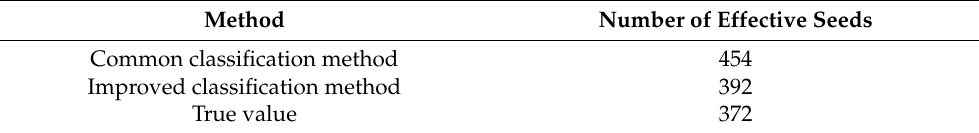
Table 10. Counting results of effective seeds number for vegetable soybean by different methods.